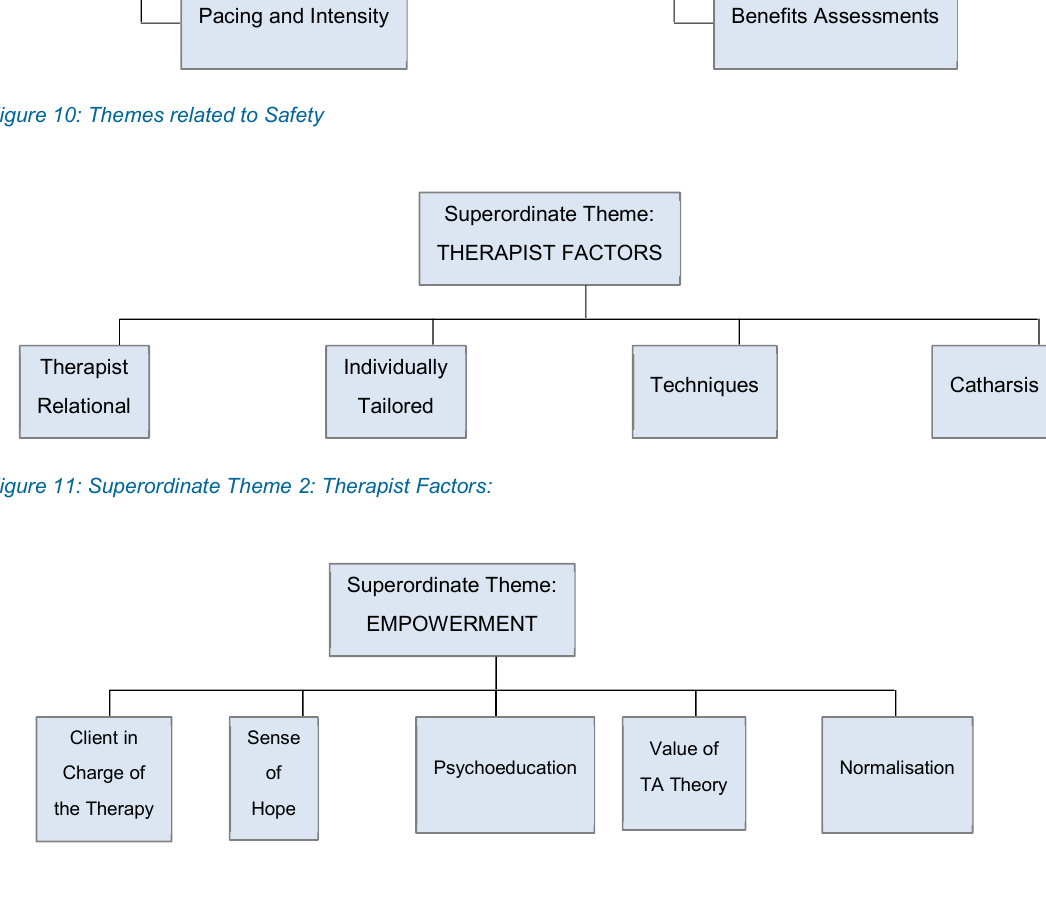
Figure 10: Themes related to Safety